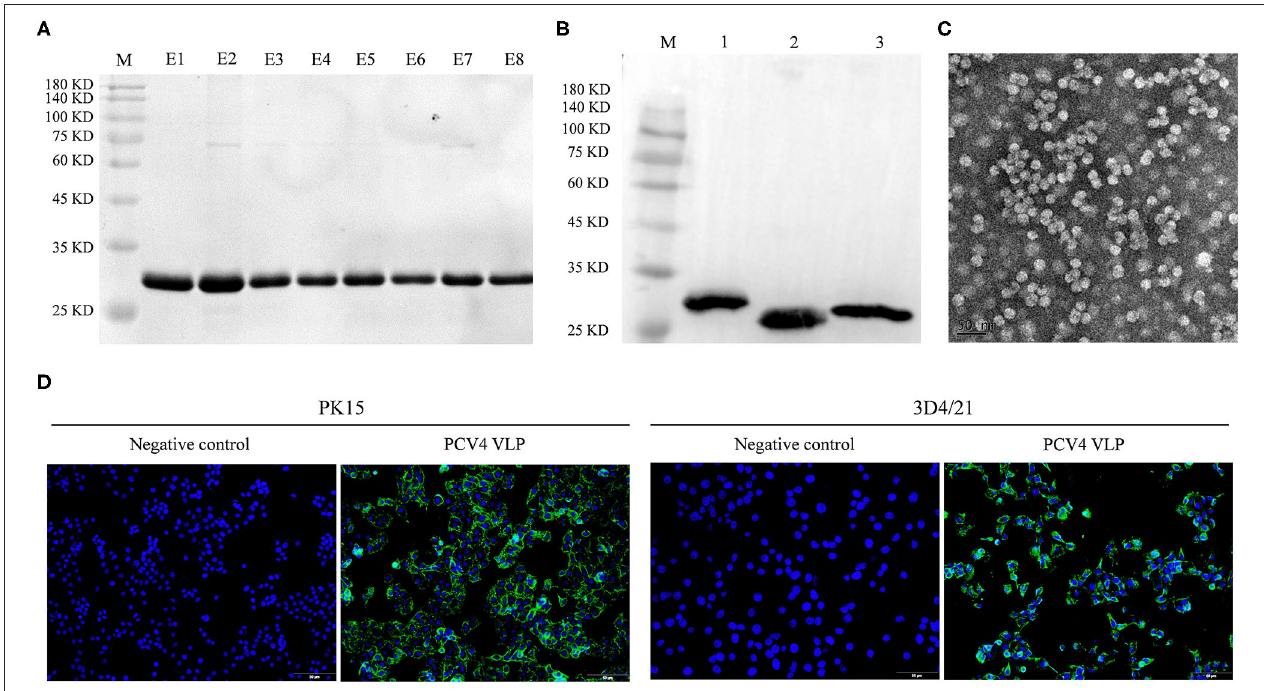
FIGURE 1 | (A) Coomassie blue-stained SDS-PAGE of purified PCV4 Cap protein (lane M: protein marker; lanes E1–E8: purified PCV4 Cap protein). (B) Western blots of PCV Cap proteins using mouse anti-6 × His tag antibody (lane M: protein marker; lane 1: PCV4 Cap; lane 2: PCV3 Cap; and lane 3: PCV2 Cap). (C) Formation of PCV4 VLPs observed with TEM. (D) Entry of PCV4 VLPs into PK15 and 3D4/21 cell lines was confirmed by fluorescence microscopy. Green fluorescence represents PCV4 Cap in cells, whereas cell nuclei (blue) were stained by